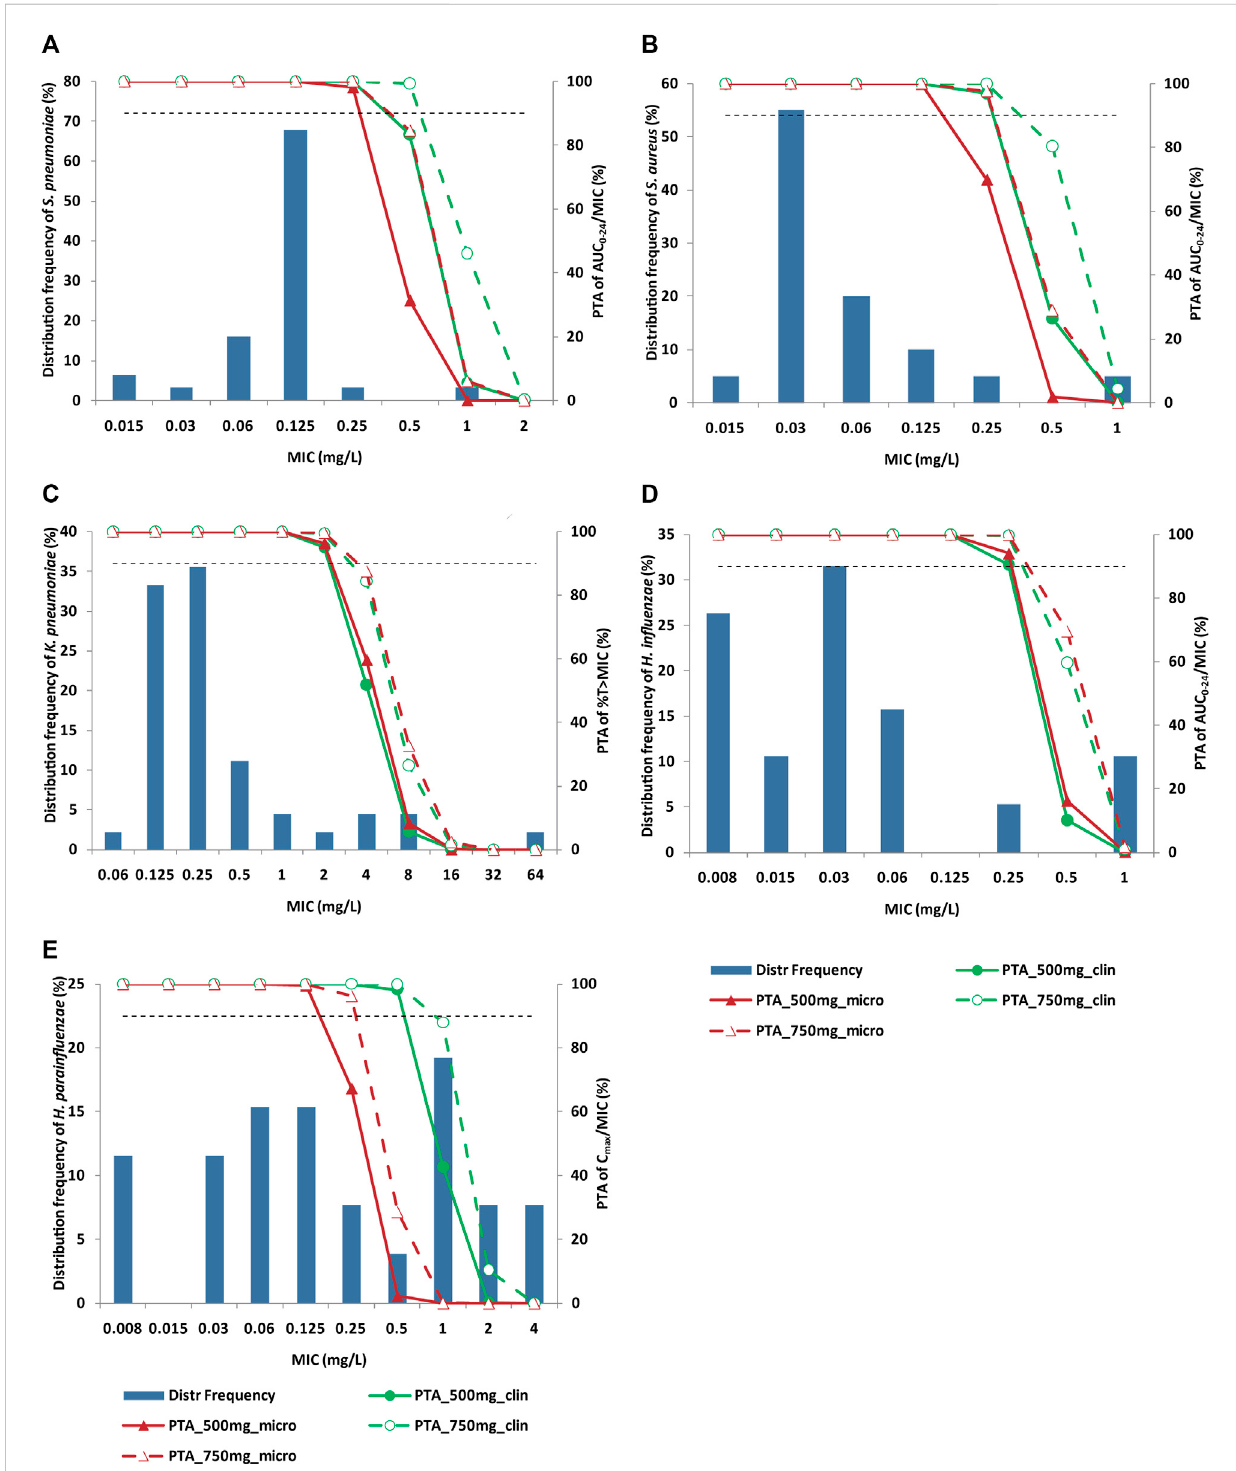
Distribution of nemonoxacin MIC against speci fi c pathogen and PTA of PK/PD index. Panel (A) S. pneumoniae ; Panel (B) S. aureus ; Panel (C) K. pneumoniae ;Panel (D) H.in fl uenzae ; Panel (E) H.parain fl uenzae . Histograms and broken lines correspond to leftand right y -axis, respectively. Solid line and dash line represent PTA for nemonoxacin 500 mg q24 h and 750 mg q24 h, respectively. Green and dark red colors represent clinical and microbiological targets, respectively. Horizontal dash line denotes 90% PTA. Nemonoxacin was administered q24 h for 10 days. MIC: minimum inhibitory concentration; PK/PD: pharmacokinetic/pharmacodynamic; PTA: probability of target